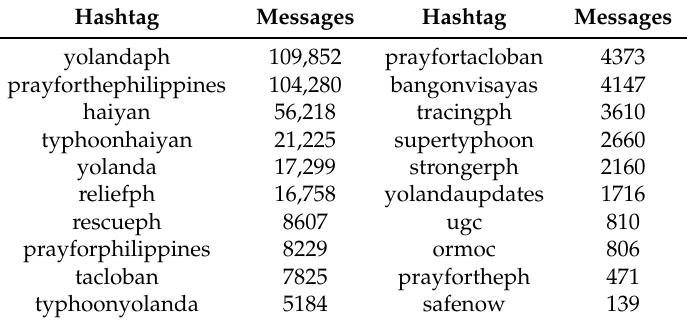
Table 4. Number of messages corresponding to